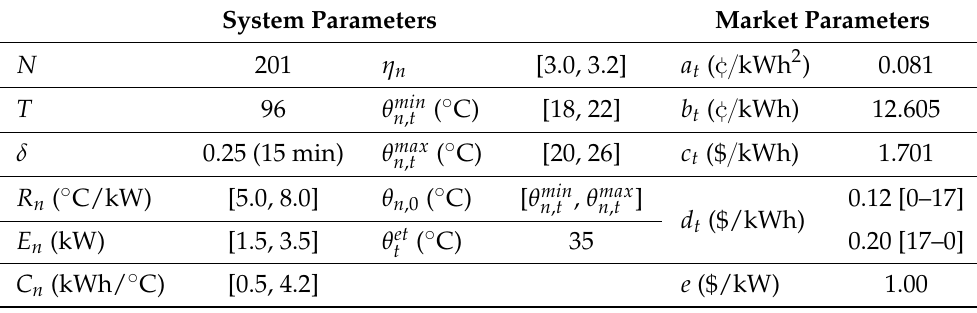
Table 2. System and market parameters generated or calculated to create the case